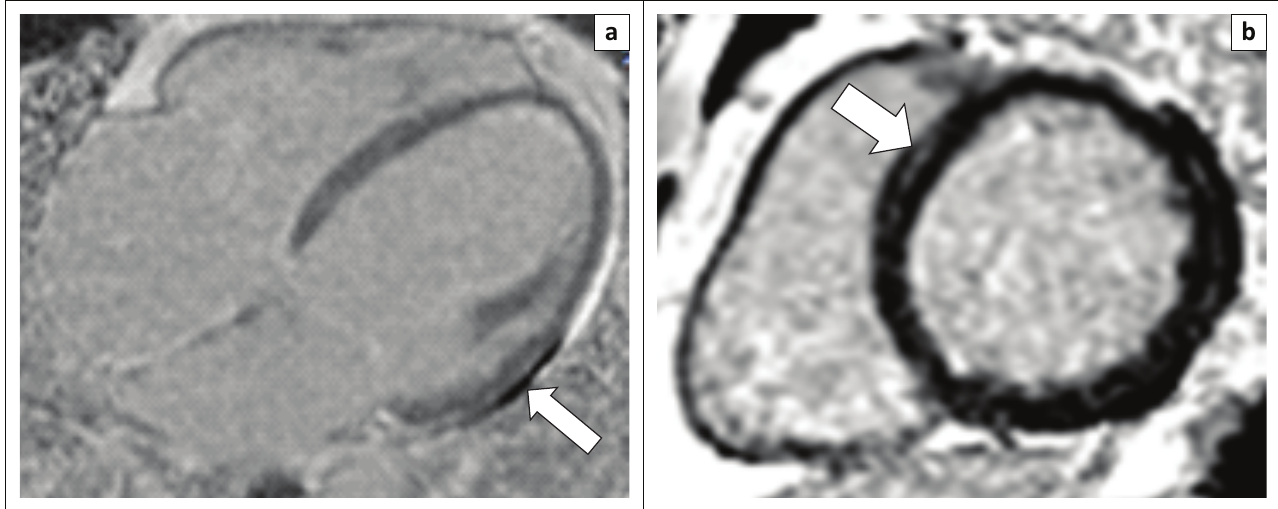
FIGURE 2: Dilated cardiomyopathy. Late gadolinium-enhanced PSIR images in four-chamber (left) and basal short-axis (right) demonstrating virtual circumferential midwall enhancement